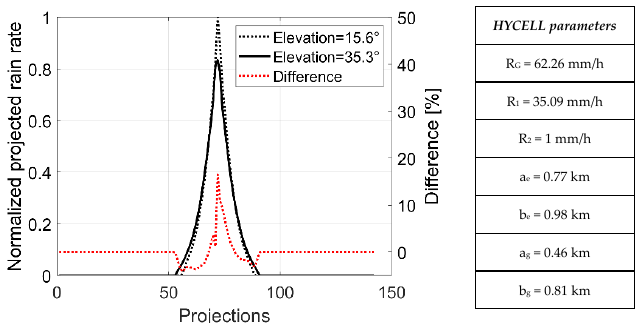
Figure 7. Rain intensity projection values for the lowest and the highest elevation angles calculated with Equation (9) for a single rain cell with the given parameters.